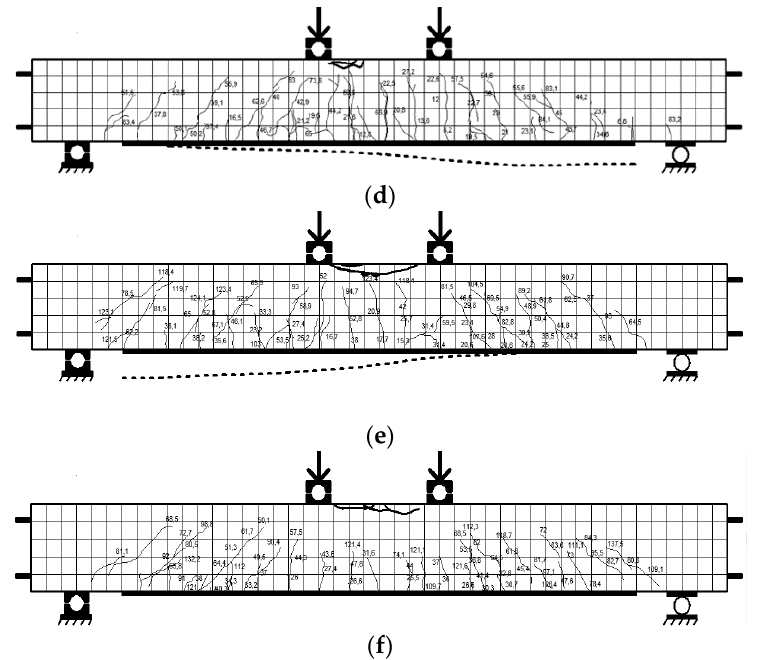
Figure 8. Crack patterns of the beams after the test ( a ) G6C1, ( b ) G6C2, ( c ) G6C3, ( d ) G6P1, ( e ) G6P2, and ( f ) G6P3.